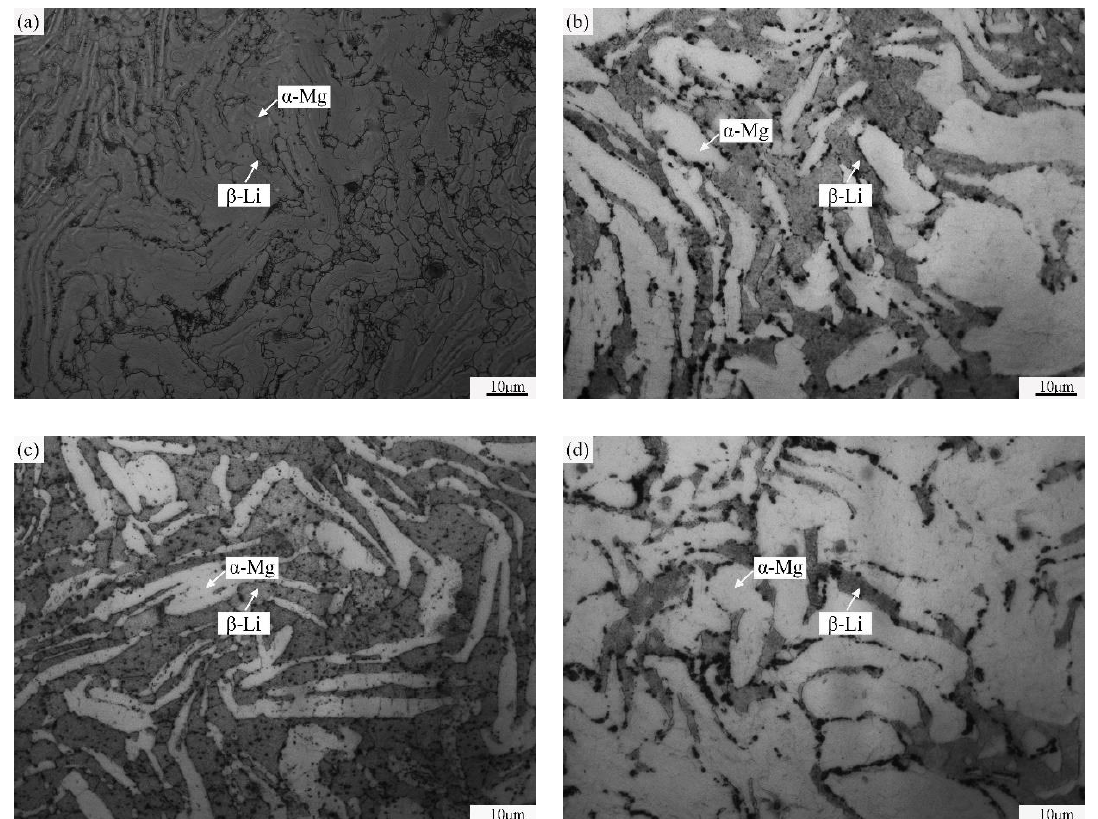
Figure 1. Microstructures of the extruded Mg–7Li–3Al–xCa alloys (perpendicular to the extrusion direction): ( a ) x = 0 ( b ) x = 0.4 ( c ) x = 0.8 ( d ) x = 1.2.